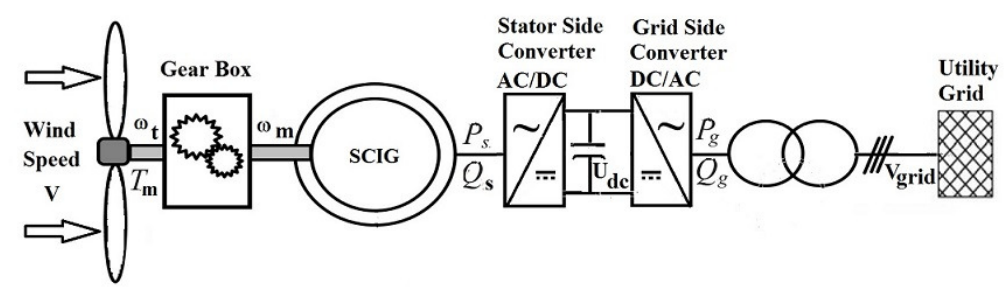
Figure 1. A block diagram representation of the squirrel cage induction generator (SCIG)-based wind energy conversion (WEC)